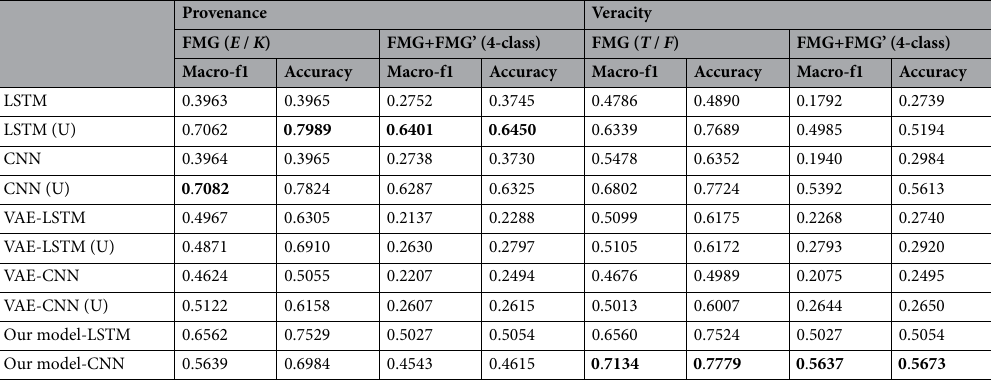
Table 6. Marco-f1 and accuracy comparison between our model and baselines on the extended 4-class experiments of provenance (real/fake) and veracity (true/false) tasks. U indicates that the model is trained on FMG+FMG’, otherwise it is train on FMG. All models are tested on FMG and FMG+FMG’. The best results are marked in